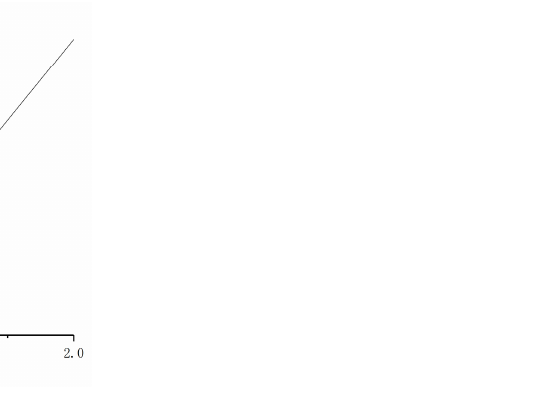
Figure 14. The eddy current density distribution of the permanent magnet and the 2 mm jacket.